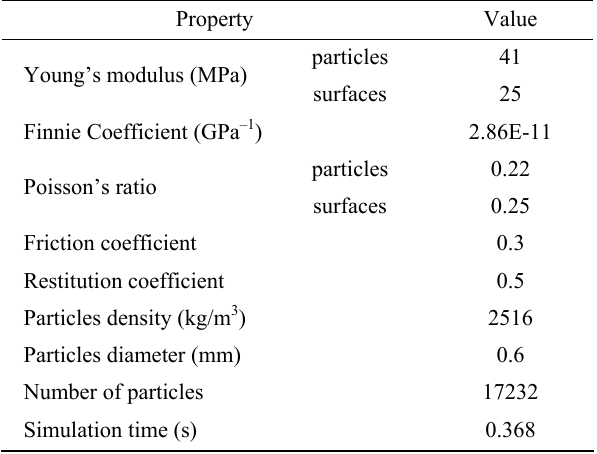
Fig. 11 Simulation of the flow erosion using the DEM. Table 2 Physical characteristics of the particles and other fixed factors in the flow-erosion simulations.